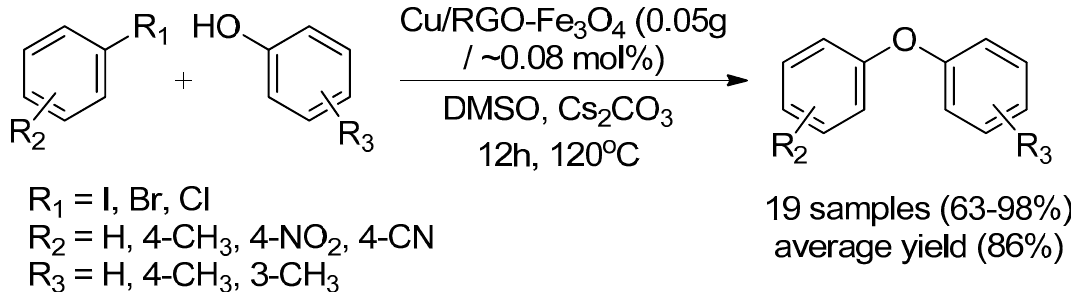
14 of 51 Figure 7. The image of graphene oxide and reduced graphene oxide (RGO).